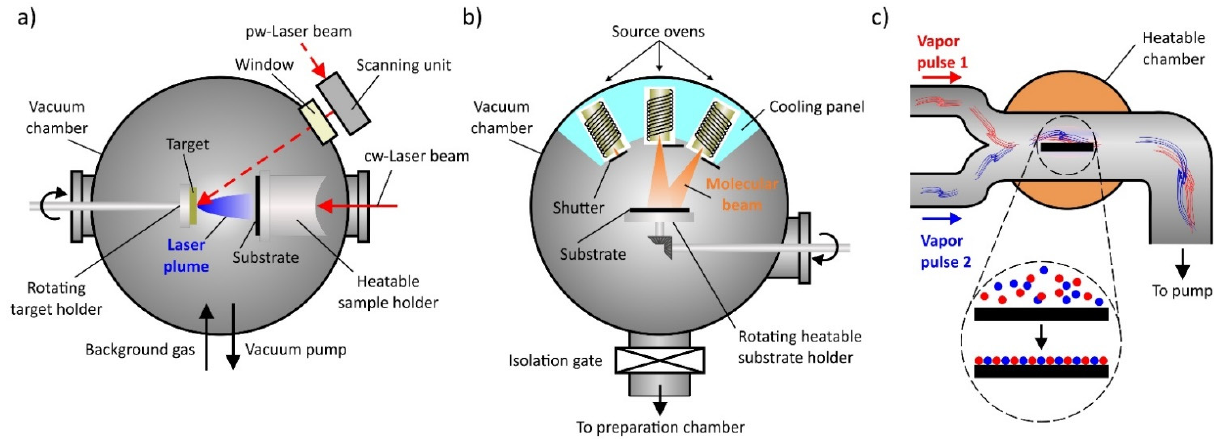
Figure 5. Schematic illustration of techniques for the deposition of ultra-thin films. ( a ) Pulsed laser deposition (PLD), ( b ) molecular beam epitaxy (MBE) and ( c ) atomic layer deposition (ALD).